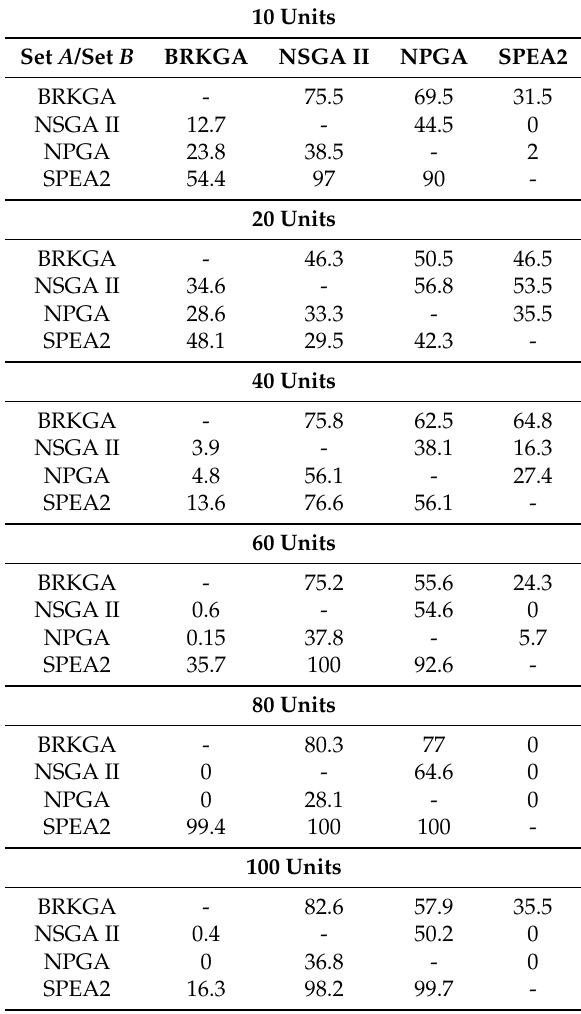
Table 12. Percentage of Non-dominated Solutions coverages of set B covered by those in set A .